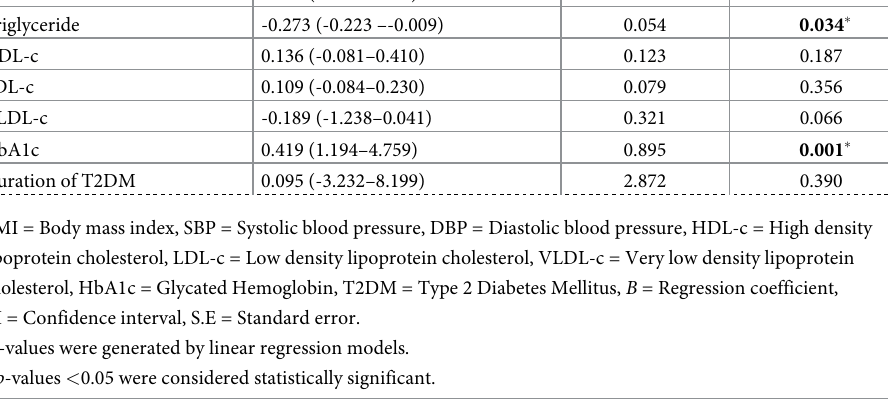
Table 4. Relationship between plasma PAI-1 antigen and BMI, BP, HbA1c, duration of diabetes mellitus and Lipid parameters among the participants.